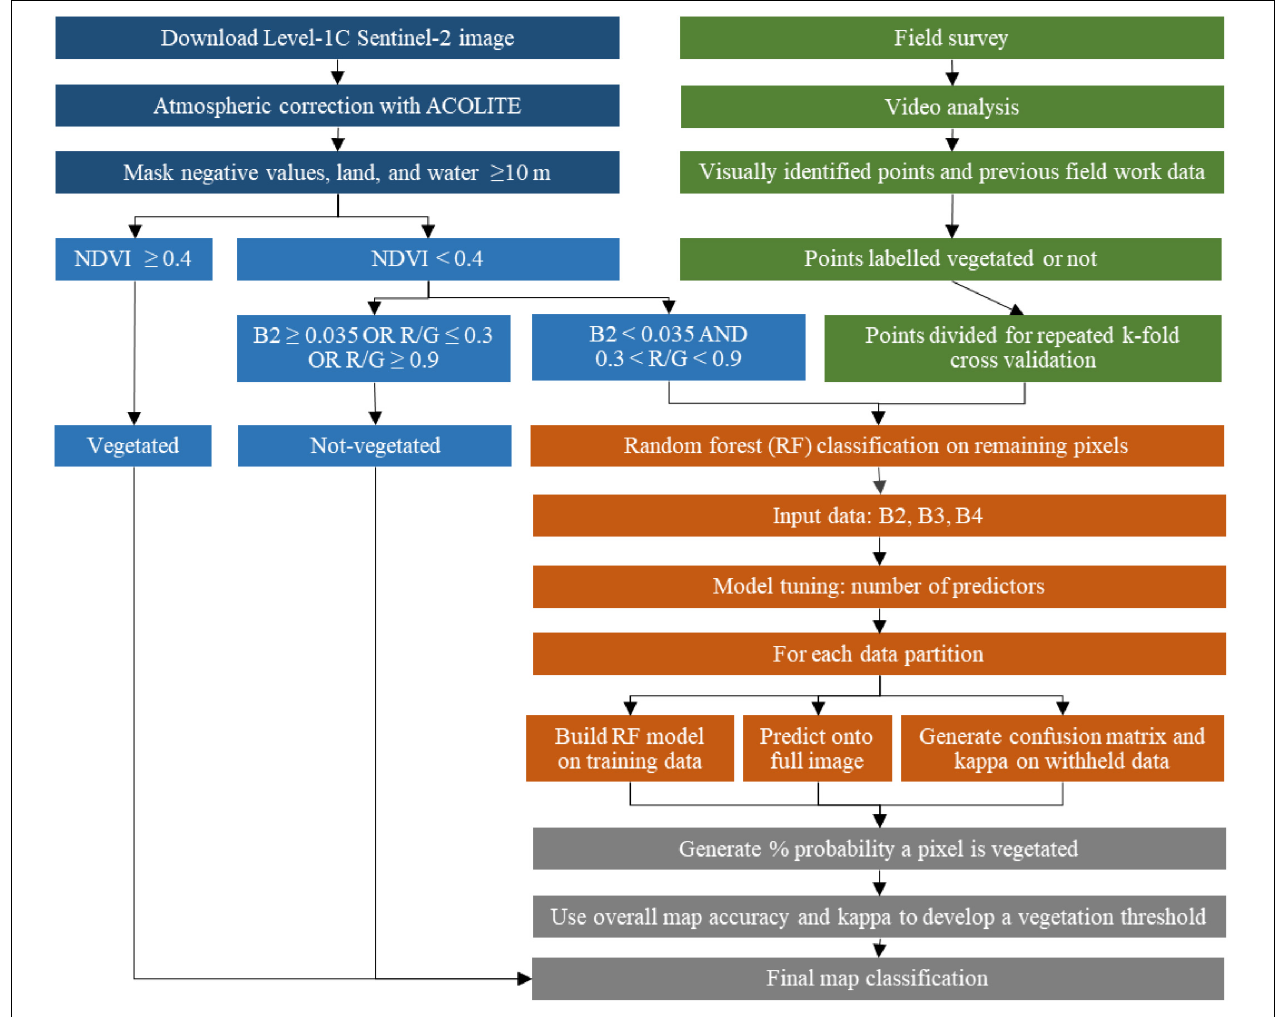
FIGURE 2 | Methods workflow to classify the Sentinel-2 tile.